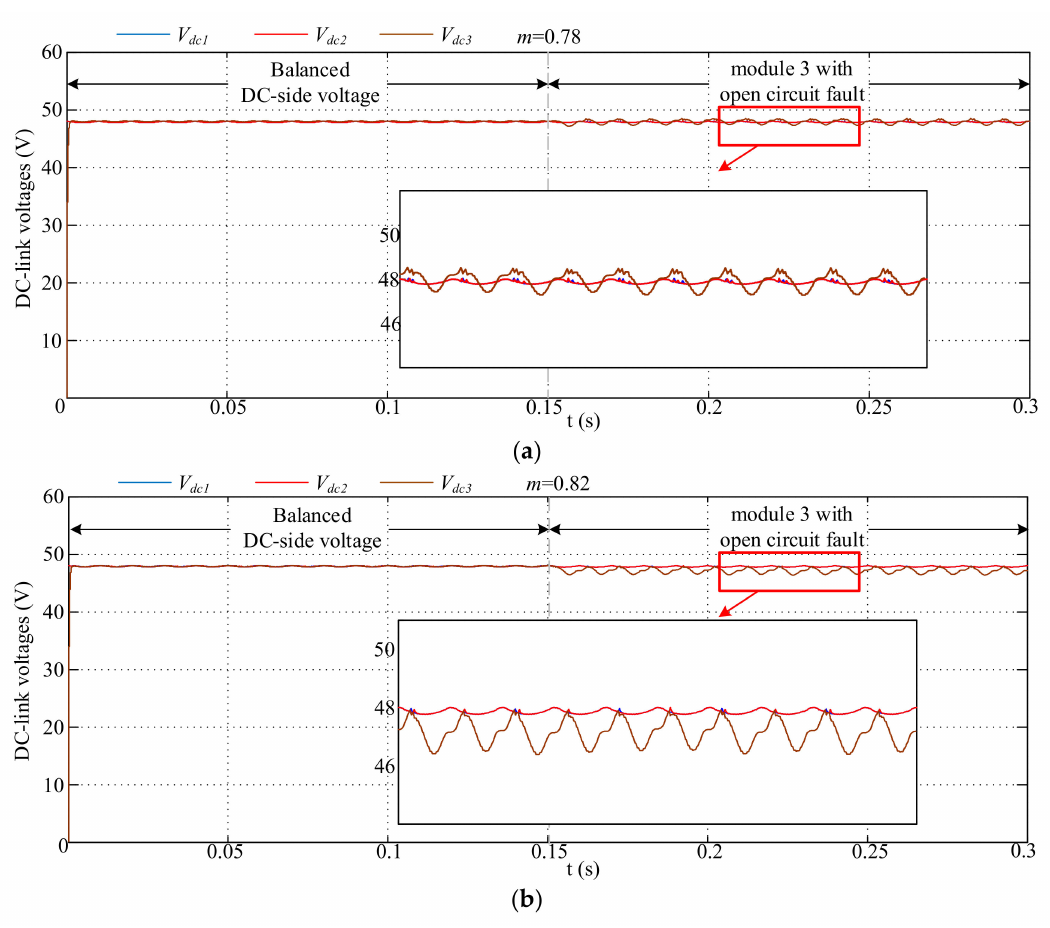
Figure 8. DC-side voltages of each module.